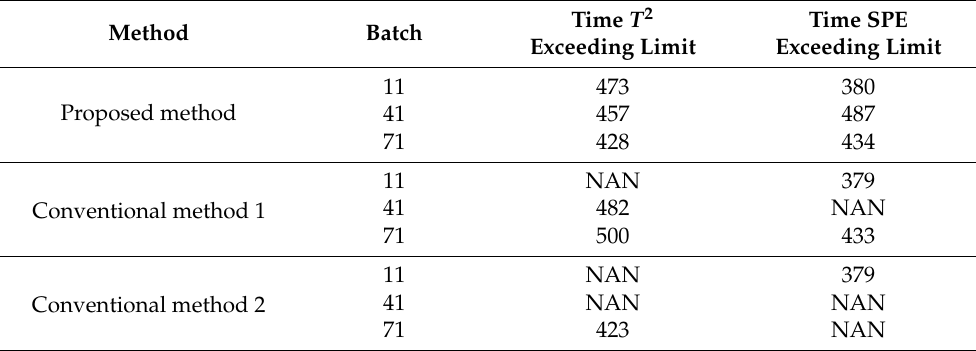
Table 3. Comparison of fault monitoring capabilities of three